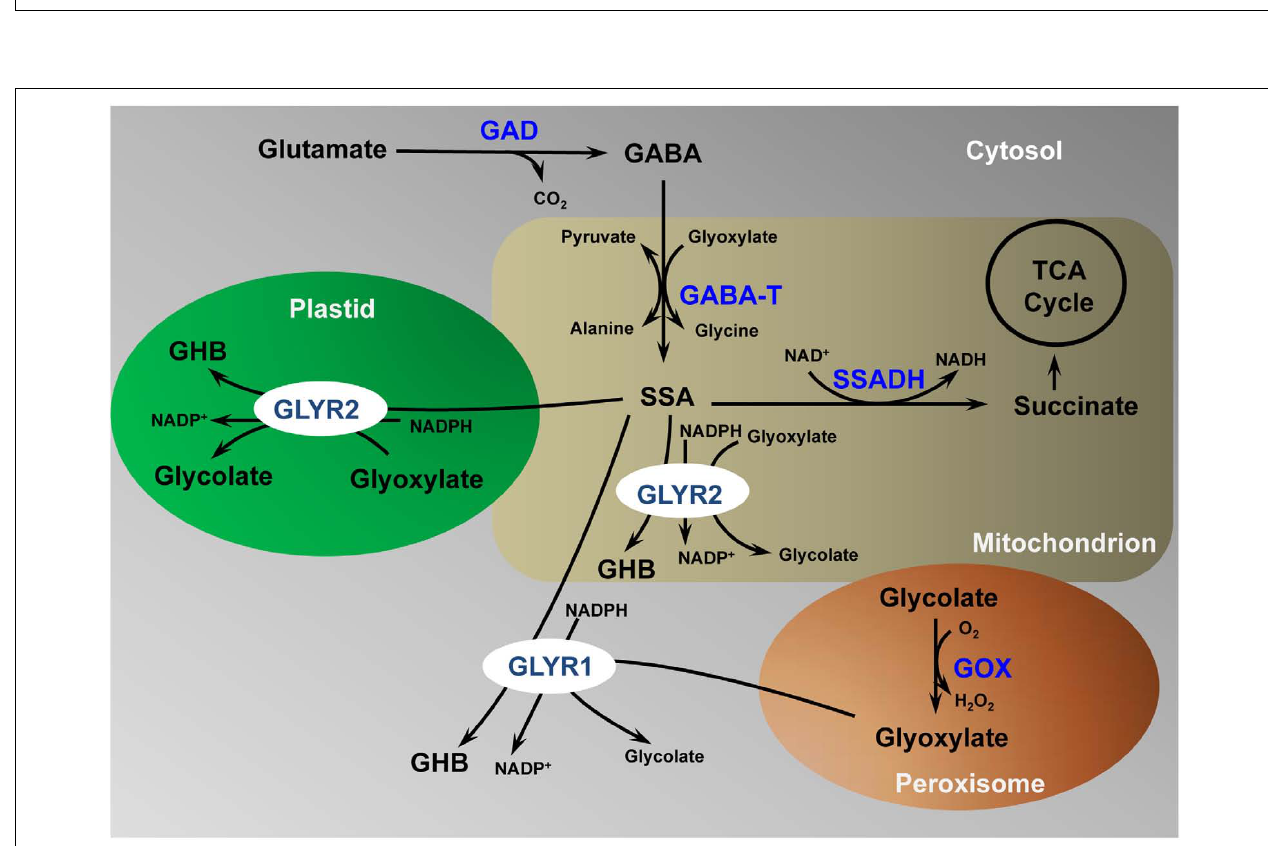
FIGURE 6 | Proposed model for the detoxification of γ -aminobutyrate-derived succinic semialdehyde and photorespiration-derived glyoxylate in multiple subcellular compartments. γ -aminobutyrate, GABA; GABA transaminase, GABA-T; glutamate decarboxylase, GAD; glycolate oxidase, GOX; glyoxylate reductase, GLYR; γ -hydroxybutyrate, GHB; succinic semialdehyde, SSA; tri-carboxylic acid cycle, TCA. (Modified from Shelp et al. (2012); permission to reproduce not required)